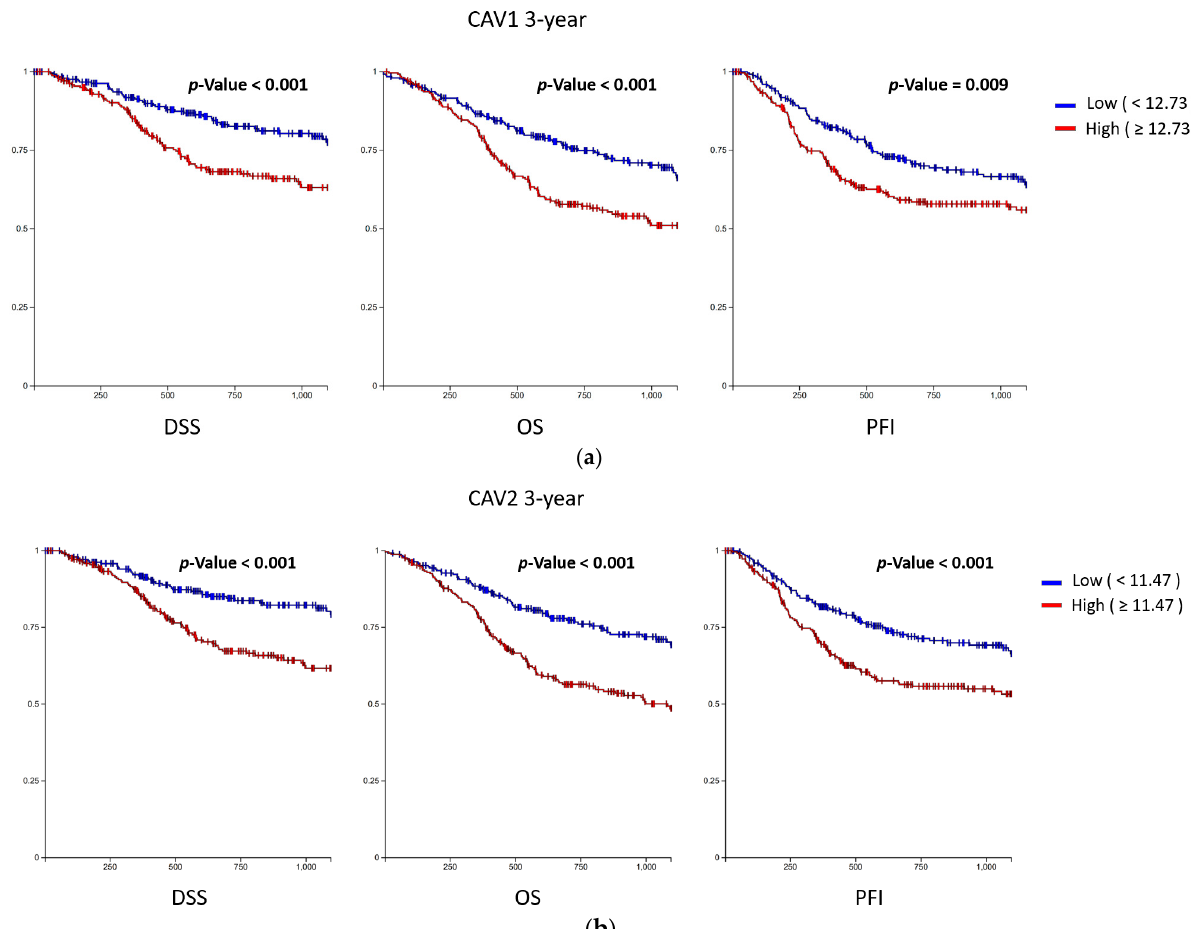
Figure 4. K–M survival curve. The DSS, OS and PFI of CAV1 ( a ) and CAV2 ( b ) are shown at a 3-year cutoff, respectively. Significant differences are found in multiple survival parameters between the high-expression group and the low-expression group. Table 2. Cox regression analysis. The result of univariate and multivariate Cox regression analysis indicates that CAV1 expression may be a prognostic factor of DSS and OS, and CAV2 expression may be an independent prognostic factor of DSS, OS and PFI. All p -values less than 0.05 are bold.